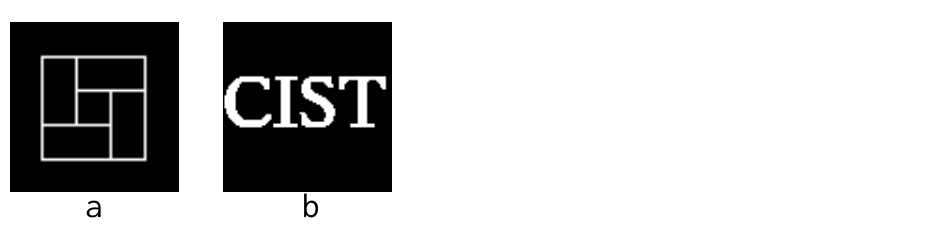
Figure 1. ( a ) Rectangular target irradiance distributions, ( b ) the characters “CIST” target irradiance distributions.